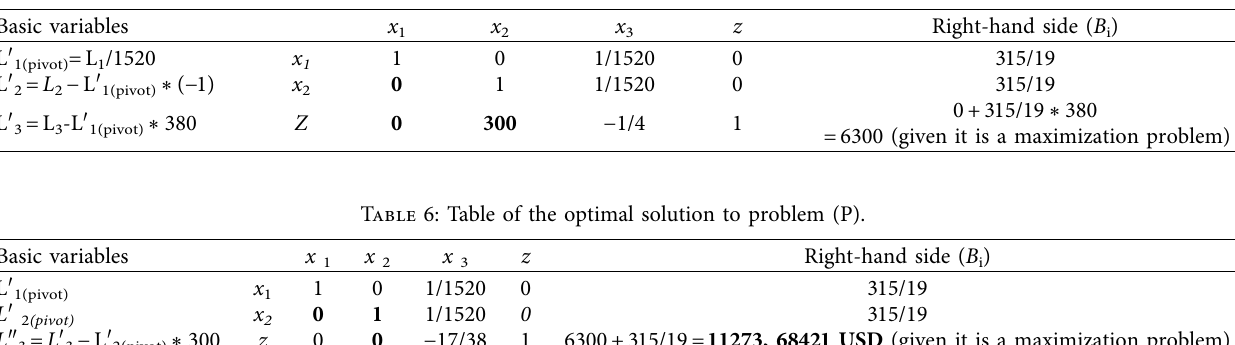
Table 5: New Simplex table with x 1 as a new basic variable that replaces x 3 .